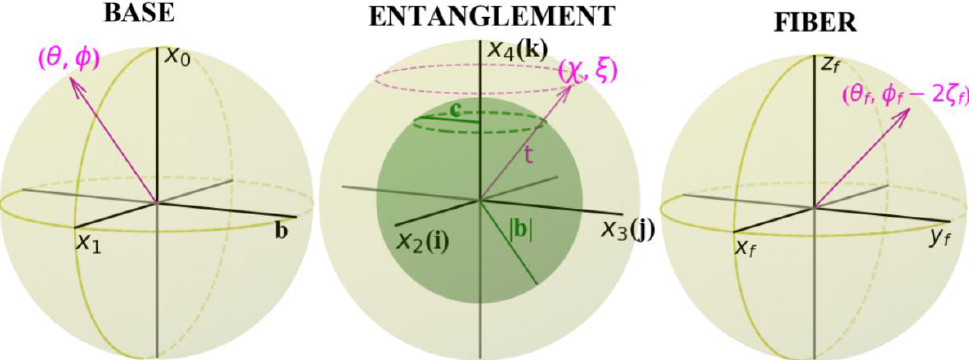
Figure 4. The two-qubit Bloch sphere: the base sphere with angle coordinates ( θ , φ ), the entanglement sphere ( χ , ξ ), the fiber sphere ( θ f , φ f − 2 ζ f ), and the phase factor ζ f . The entanglement sphere illustrated is for concurrence c = 0.5 and t = ( j + k )/ 2.